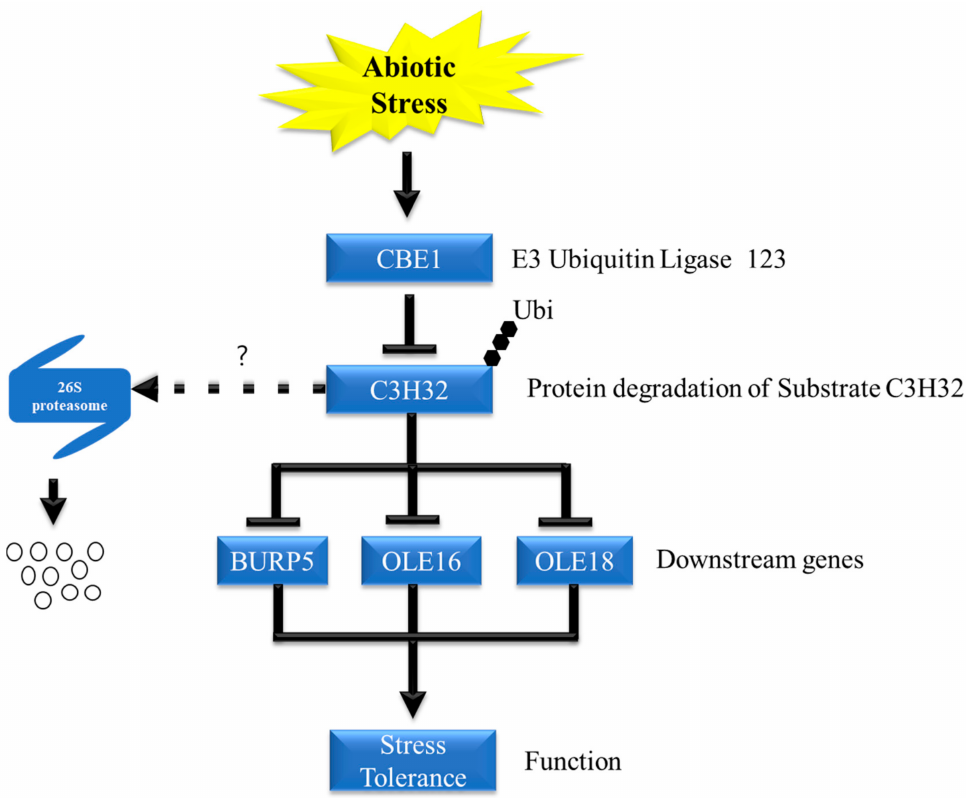
Figure 7. Model of OsCBE1 functioning in regulating abiotic stress response in rice. The arrow represents activation while the flat arrow represents inhibition. The dotted arrow and question mark represent hypothesis about how it